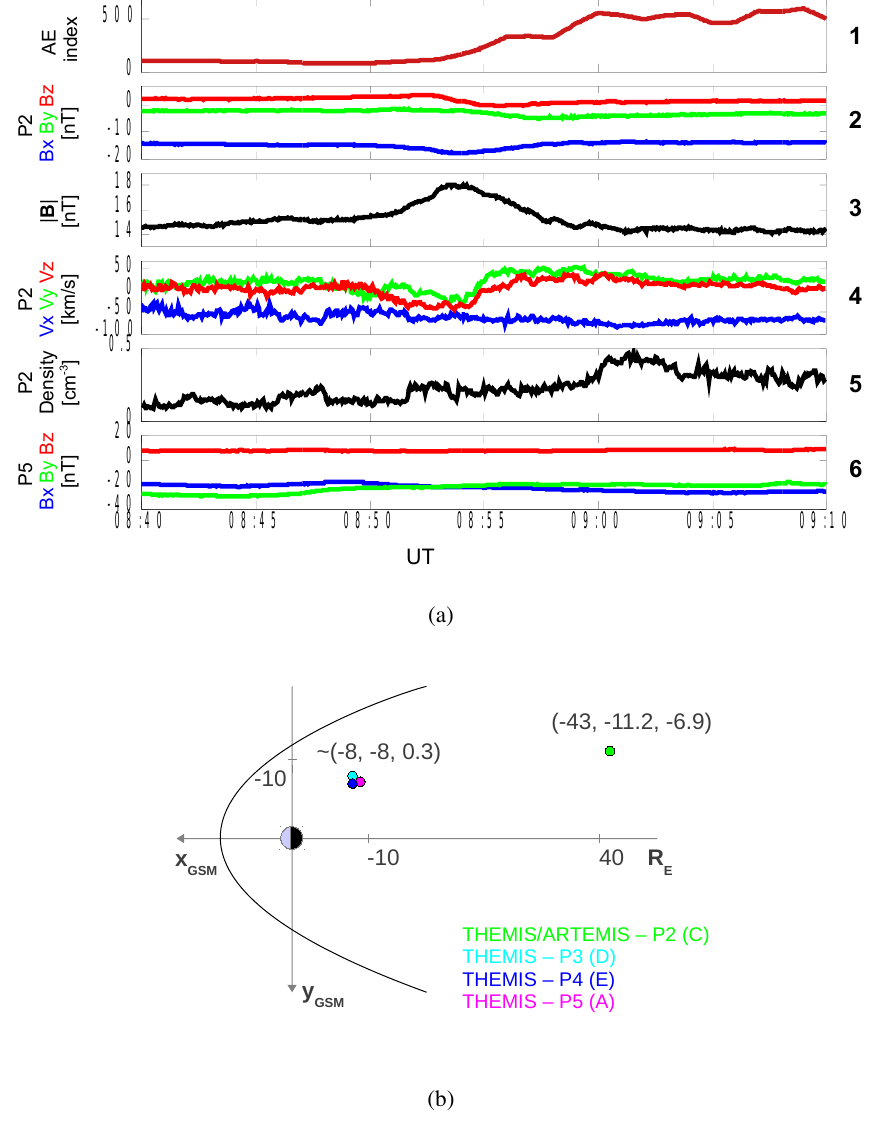
Fig. 3. (a) 15 February 2010 substorm event overview. From top to bottom: auroral electrojet index; THEMIS/ARTEMIS P2 magnetic field components; magnetic field magnitude; plasma velocity components; plasma density; THEMIS P5 magnetic field components. The data are presented in GSM coordinate system. (b) Positions of the satellites in GSM coordinates.